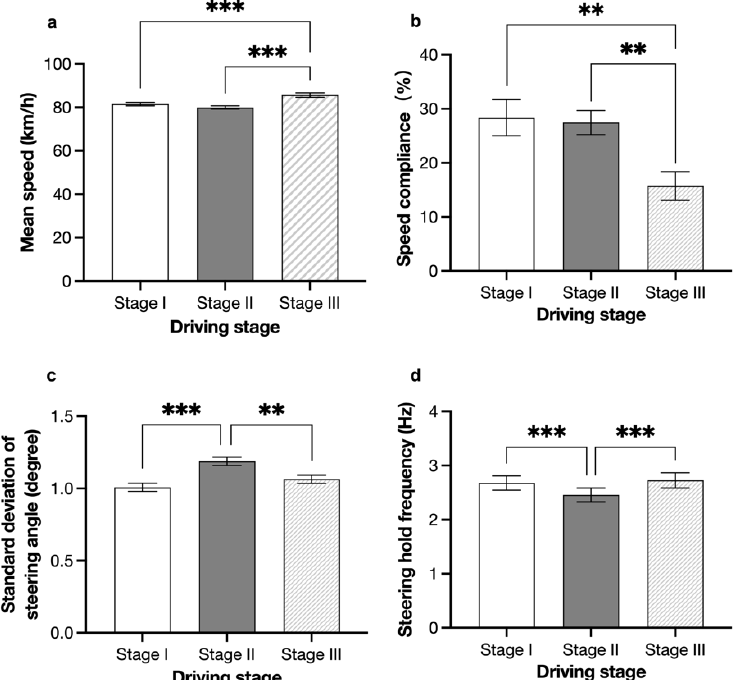
Figure 10. Vehicle dynamics under three driving stages. (Note: ( a ) represented analysis of drivers’ mean speed; ( b ) represented analysis of drivers’ speed compliance; ( c ) represented analysis of drivers’ the standard deviation of steering angle; ( d ) represented analysis of drivers’ steering hold frequency. Two asterisks (**) indicate p < 0.01, and three (***) indicate p < 0.001).